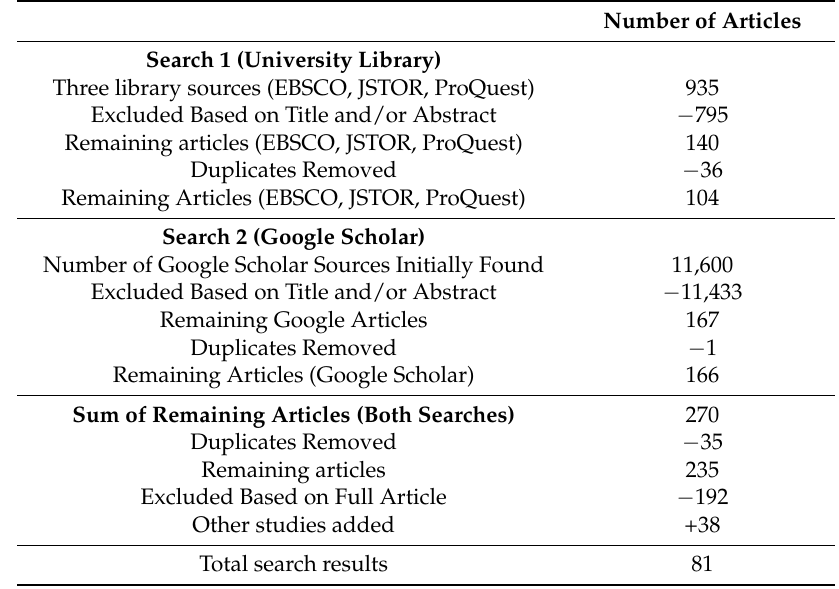
Table 1. Overview of Article Sources and Exclusions.